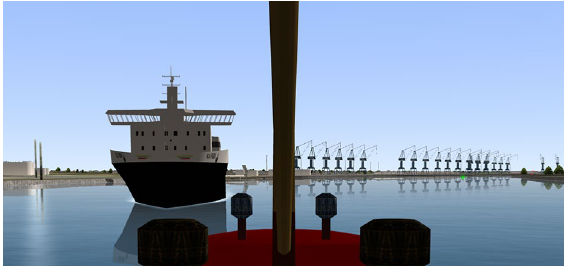
Fig. 1. Ships sailing in narrow